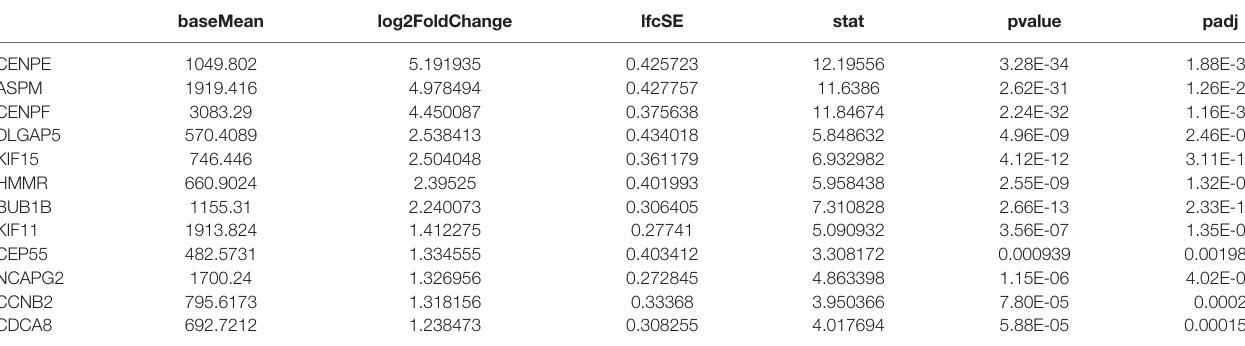
TABLE 1 | The expression pro fi les of 12 upregulated overlapping genes in AML samples. baseMean log2FoldChange lfcSE stat pvalue padj